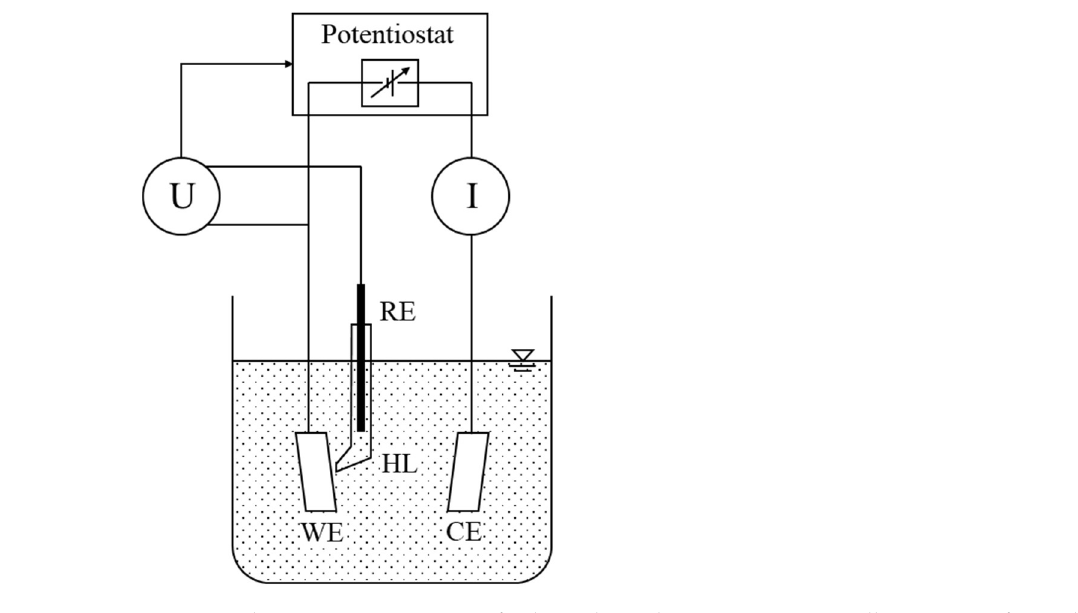
Figure 1. Schematic representation of a three-electrode macro-corrosion cell consisting of a working electrode (WE), reference electrode (RE), counter electrode (CE) and a potentiostat, own figure according to [19].